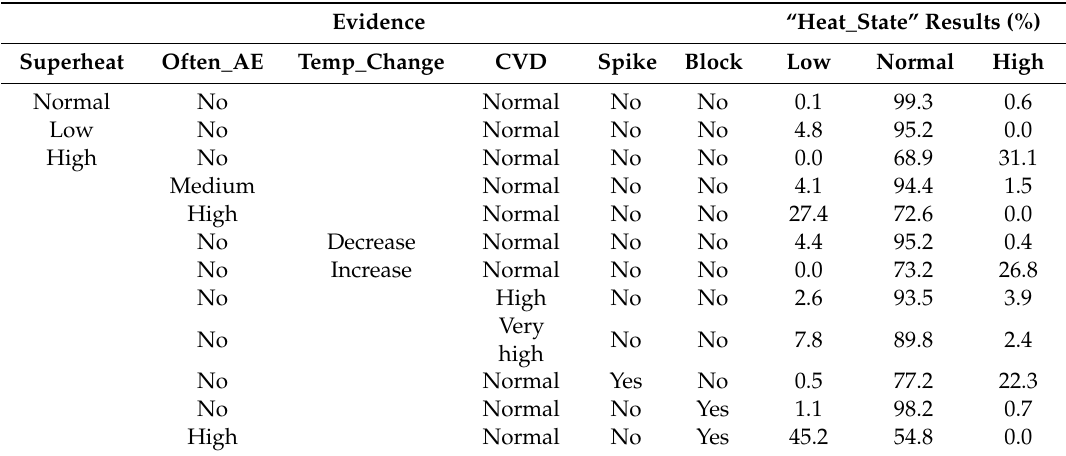
Table 3. “Heat_state” results under some evidence